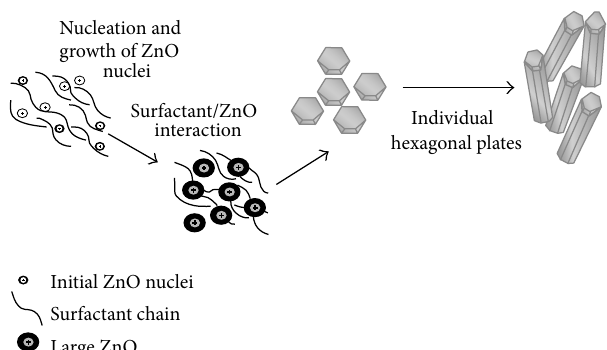
Figure 4: Schematic representation of ZnO nanorods formation mechanism.